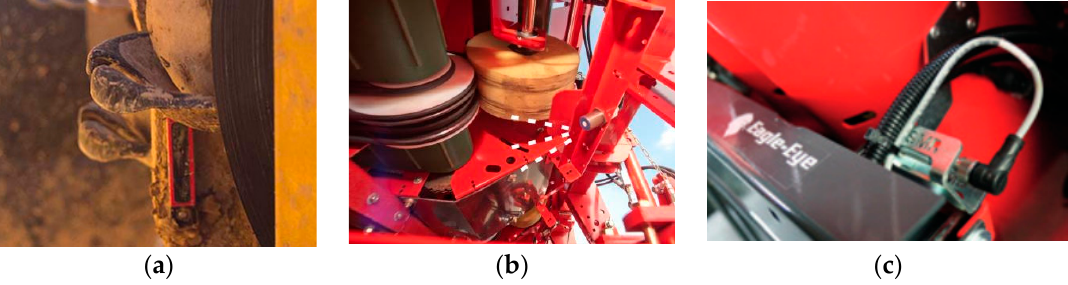
Figure 20. Seeding monitoring sensor: ( a ) Double L photo electric sensor. Reprinted with permission from ref. [12]. Copyright 2021 Double L Industries; ( b ) GB430 ultrasonic sensor Reprinted with per- mission from ref. [89] Copyright 2022 Grimme Industries; ( c ) Dewulf CP series Eagle-Eye. Reprinted with permission from ref. [72]. Copyright 2021 Dewulf Industries.